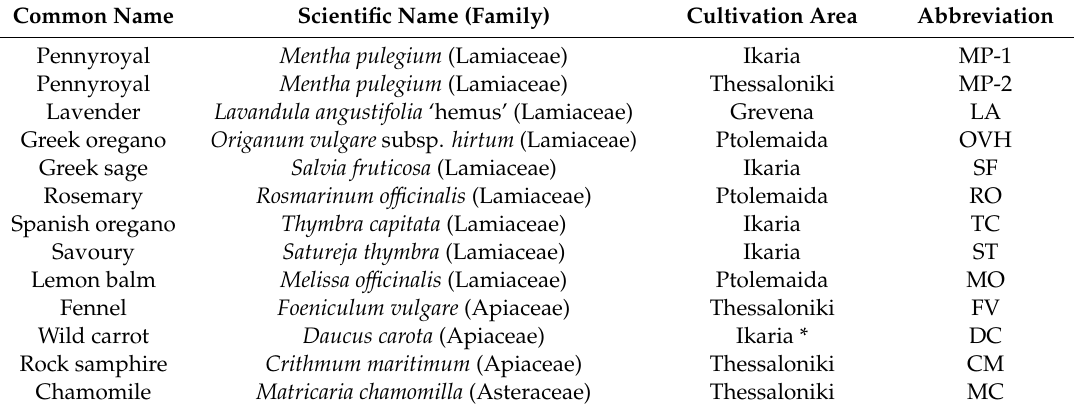
Table 4. Plant species used for the extraction of the 13 essential oils under